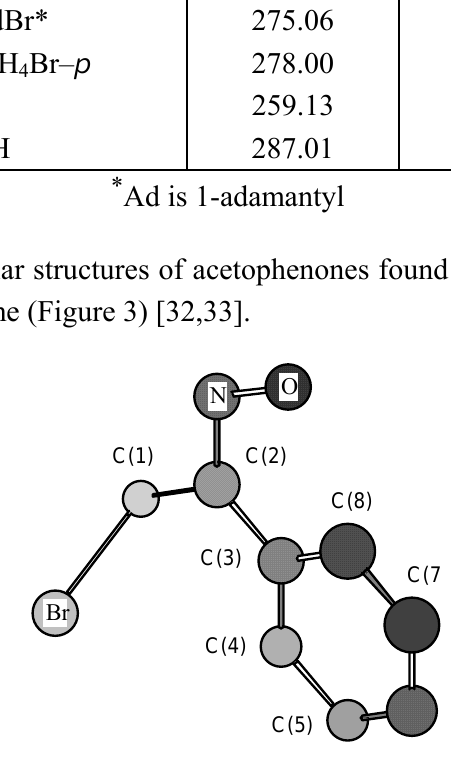
Figure 3. Structure of anti- α -bromoacetophenone